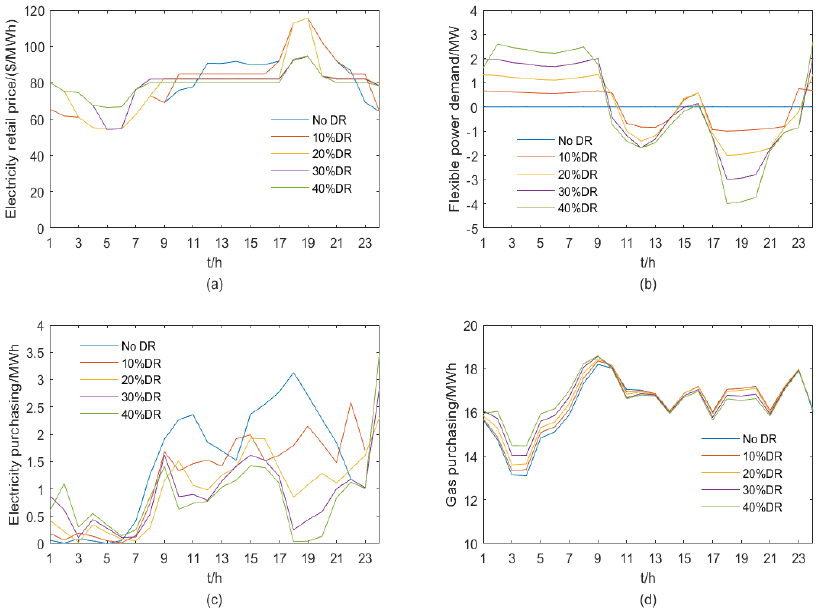
Figure 5. ( a ) Electricity retail price, ( b ) flexible power demand, ( c ) electricity bought from the whole- sale market and ( d ) gas bought from the wholesale market with different DR.